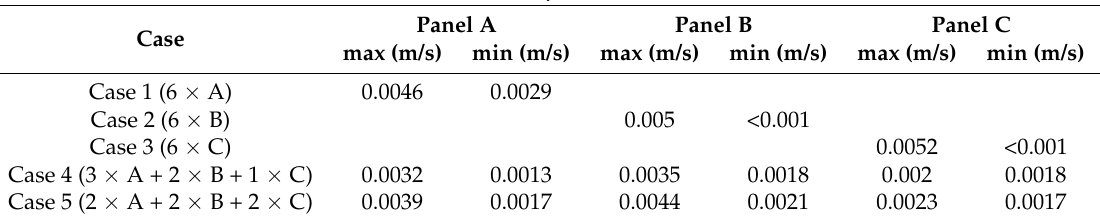
Table 2. Maximum and minimum velocities per panel type in the five different configurations presented in